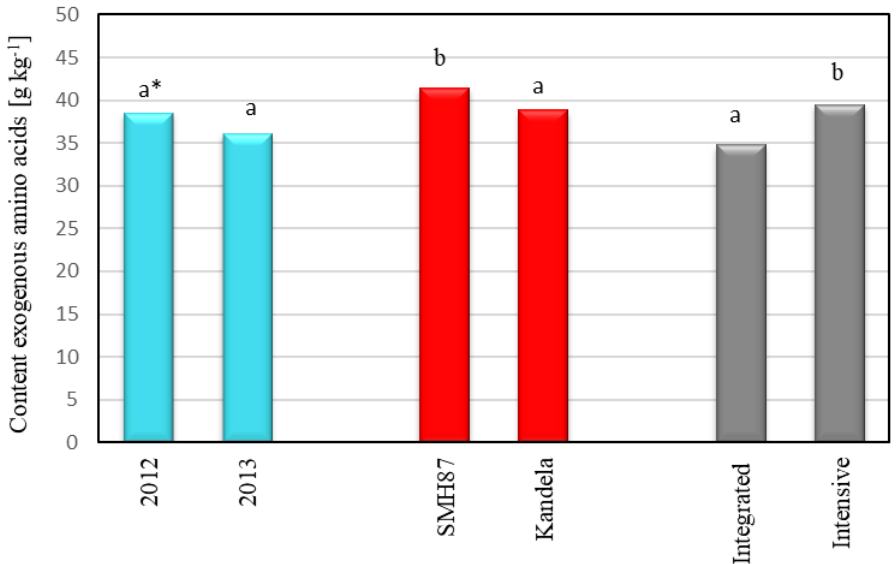
Figure 3. Content of exogenous amino acids in wheat grain depending on the year of harvest, cultivar and production technology. * Different letters (a, b) are significantly different (α = 0.05).